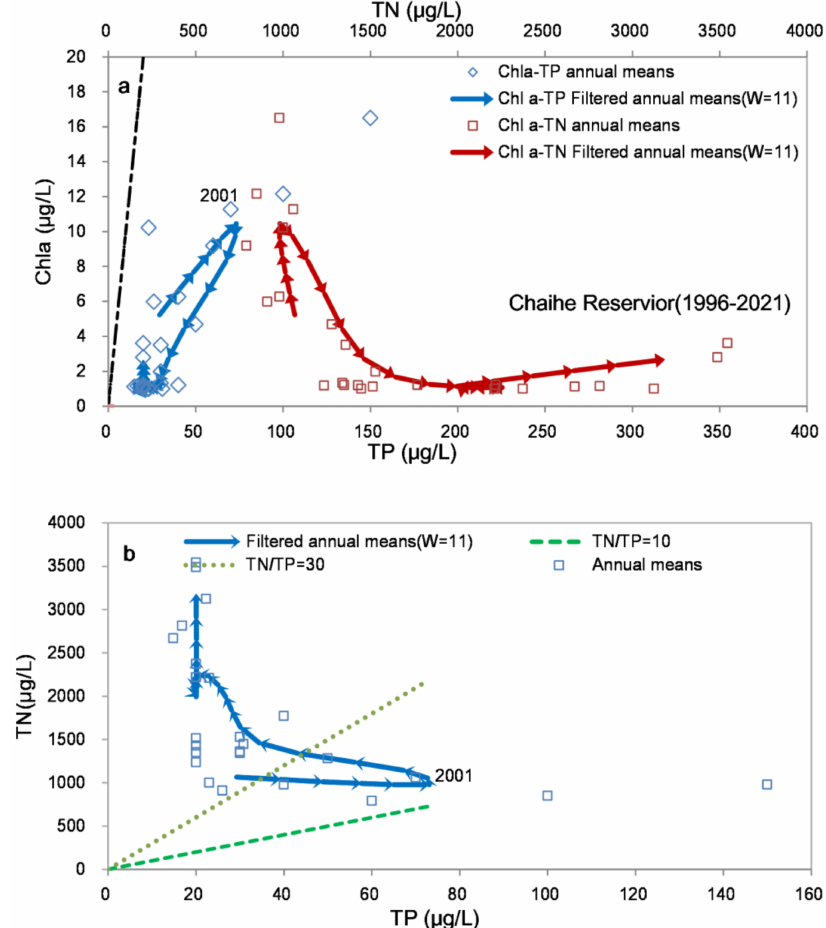
Figure 3. ( a ) Filtering trajectory diagram of Chl a -TP and Chl a -TN in the Chaihe Reservoir (1996–2021); ( b ) Filtering trajectory diagram of TN-TP in the Chaihe Reservoir (1996–2021) (the arrow denotes the time direction, where one arrow denotes 1 year. The arrow end represents the data of the year i, and the arrowhead represents the data of the year i+1. W is the number of years in the filtering